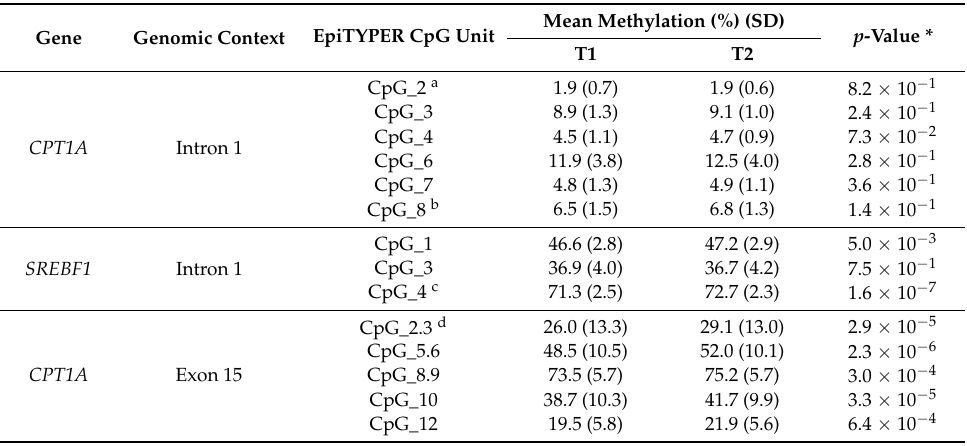
Table 1. Comparison between T1 and T2 methylation levels of CPT1A and SREBF1 variably methylated sites ( n =